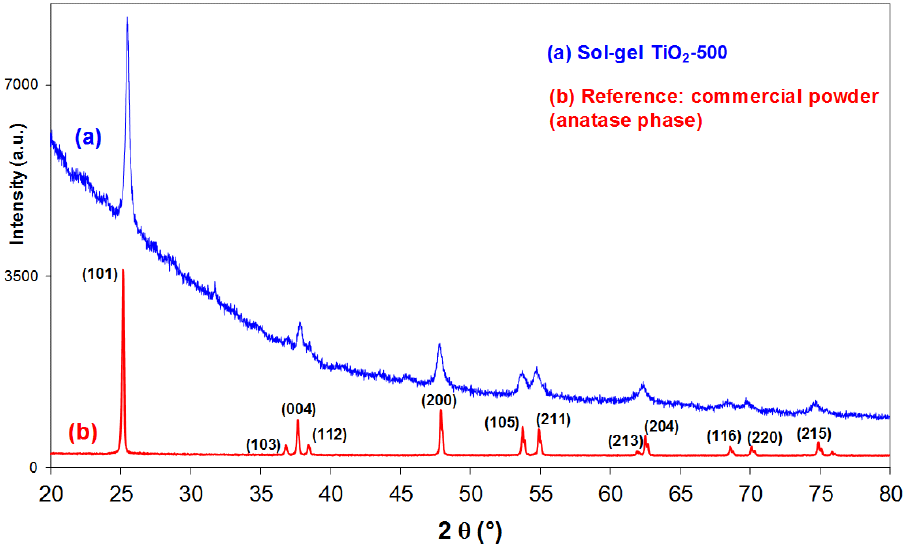
Figure 2. X-ray diffraction patterns of TiO reference